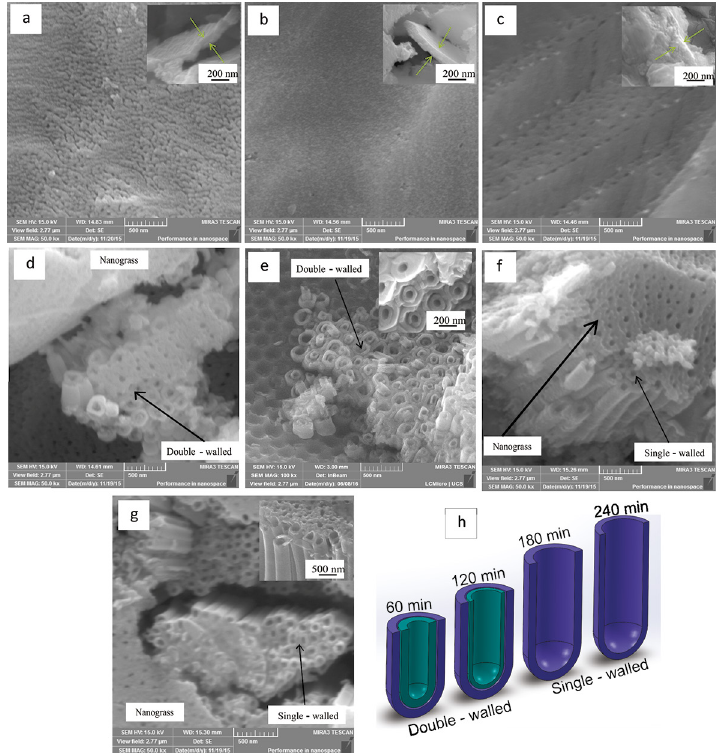
nanotubes anodized for (a) 5 minutes, (b) 15 minutes, Figure 2. FEG-SEM images of TiO 2 (c) 30 minutes, (d) 60 minutes, (e) 120 minutes, (f) 180 minutes and (g) 240 minutes. Insets show the top-view images, (h) schematic diagram showing the formation of double-walled and single-walled TiO 2